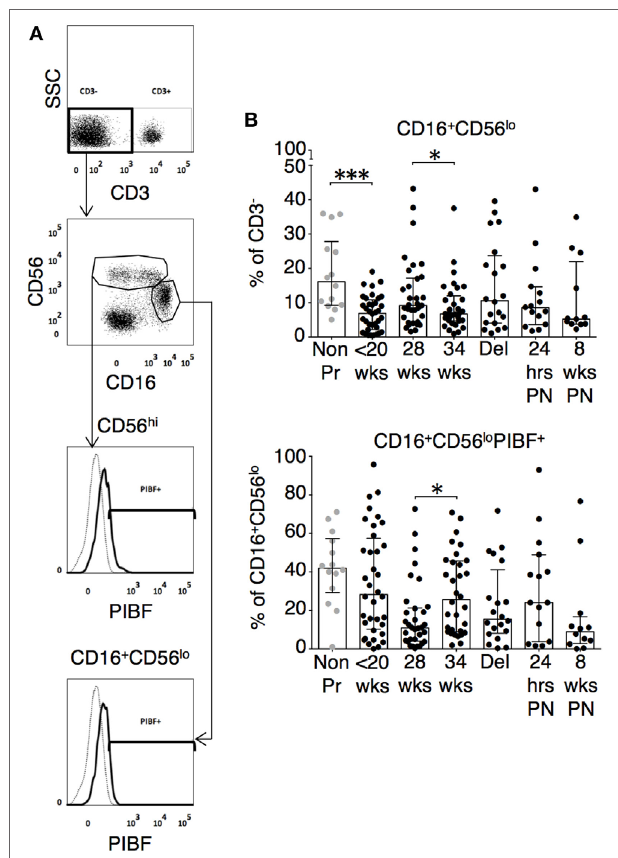
FigUre 4 | Cytotoxic natural killer (NK) cell subtype with the phenotype CD16 + CD56 lo are reduced and show an increase in P4-induced blocking factor (PIBF) expression in late pregnancy. (a) Representative flow cytometry plots are shown for NK cell subsets. (B) Longitudinal analysis of CD16 + CD56 lo and their PIBF expression during pregnancy and compared with gestation matched controls. Gestation at sampling is indicated in pregnancy ( ⚫ ): < 20 + 0 weeks ( N = 42 ), 28 weeks ( N = 35 ), 34 weeks ( N = 33 ), at delivery ( N = 24 ), 24 h post-delivery ( N = 22 ), 6–8 weeks postnatal ( N = 13 ). Non-pregnant controls are depicted as ⚫ ( N = 14 ). P values are two tailed and significance is defined as * P < 0.05 and *** P < 0.001. Non-pregnant and baseline pregnant data analyzed by Mann––Whitney U test. Longitudinal data analyzed by generalized linear mixed effects model with gamma log-link and pairwise multiple comparisons of estimated marginal means with sequential Bonferroni